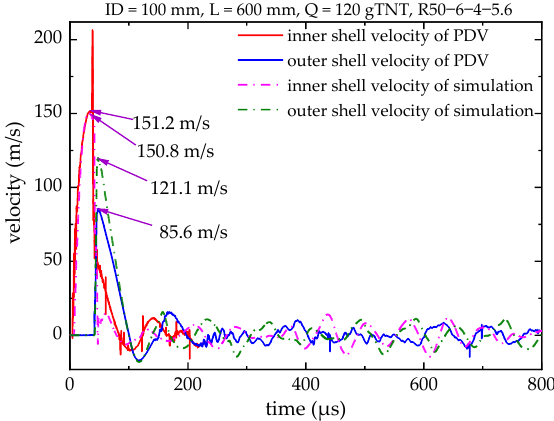
Figure 15. Velocity comparison of PDV measurement and simulation. The radial displacement curves of the double-layer steel cylinders given by numeri- cal simulation and PDV measurements are shown in Figure 16, which are basically matched. The maximum displacement of the inner cylinder given by simulation is 5.29 mm, while that measured by PDV is 5.41 mm, with an error of 2.2%. The maximum dis- placement of the outer cylinder given by the simulation is 2.67 mm, while that measured by PDV is 2.45 mm, with an error of 8.2%. It can be concluded that the results shown by the numerical simulation and PDV measurement are coincidental.